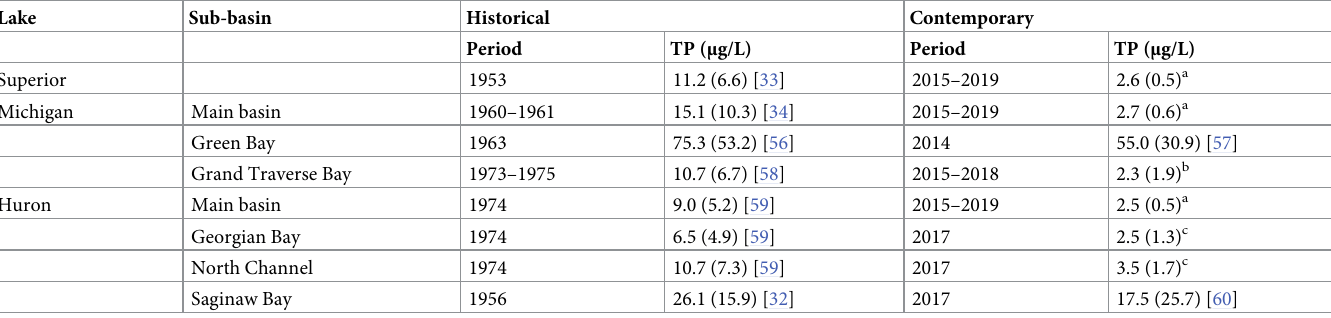
Table 1. Historical and contemporary levels of total phosphorus (TP) in the upper Great